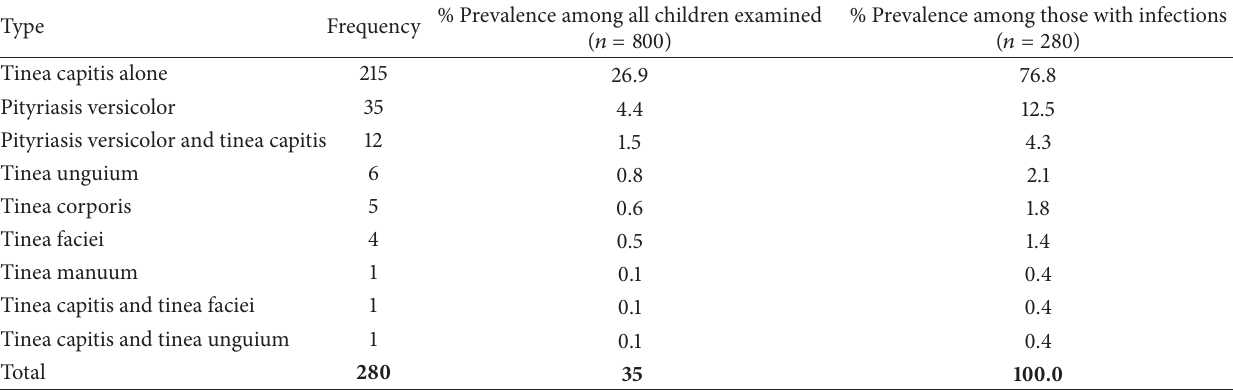
Table 2: Prevalence and Clinical types of superficial fungal infections among primary school children in Ile-Ife.